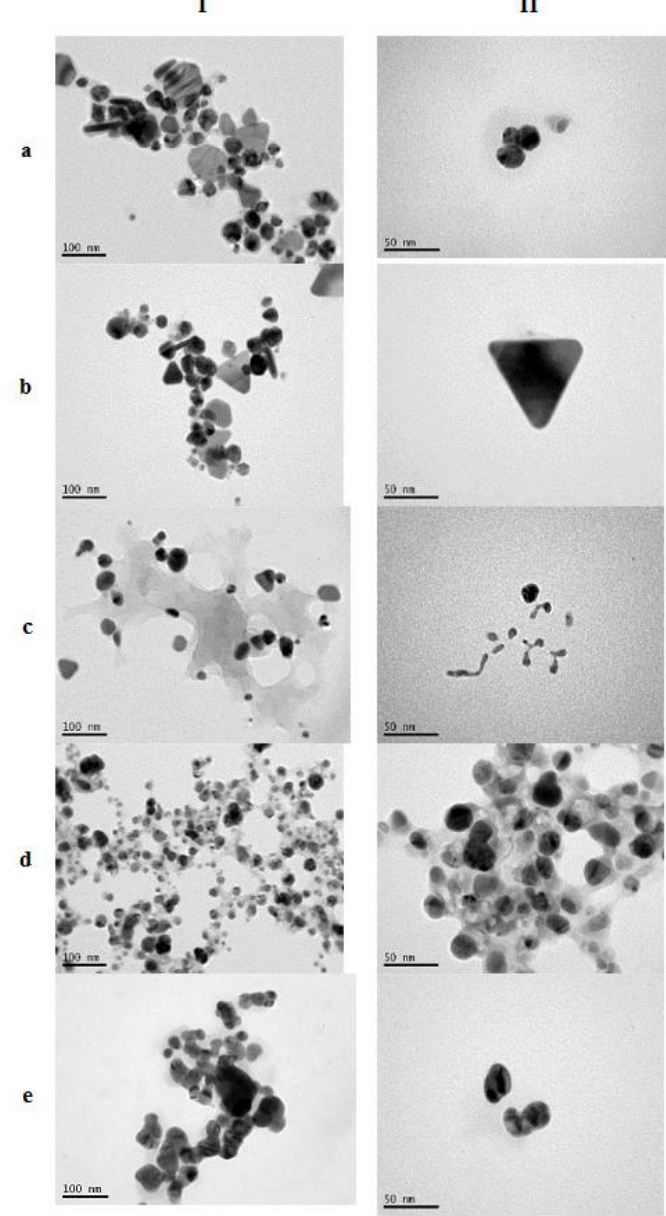
Figure 1. TEM images of ( a ) dittany, ( b ) sea buckthorn, ( c ) sage, ( d ) calendula, and ( e ) NaBH 4 AgNPs observed under × 200,000 ( I ) or × 500,000 ( II ) magnitude. Bar represents 100 nm ( I ) and 50 nm ( II ).